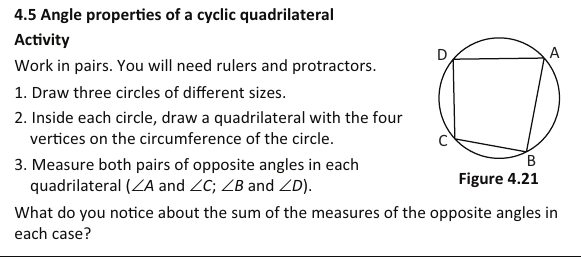
FIGURE 3: Empirical task on angle properties of a cyclic